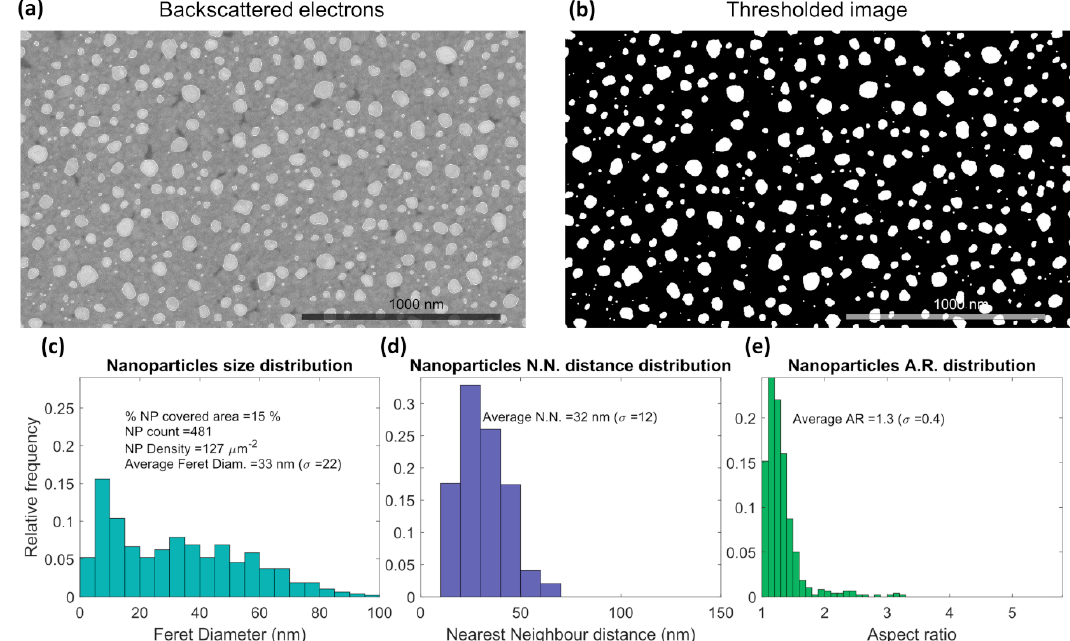
Figure 4. Au nanoparticle distribution analysis, using a MATLAB algorithm: ( a ) top-view SEM micrograph with atomic weight contrast and ( b ) processed and threshold micrograph showing the exposed Au nanoparticles, with 15% Au coverage area. Distribution histograms are displayed in ( c ) for the nanoparticles Feret diameter, ( d ) for the nearest neighbor distance, and ( e ) for the aspect ratio.